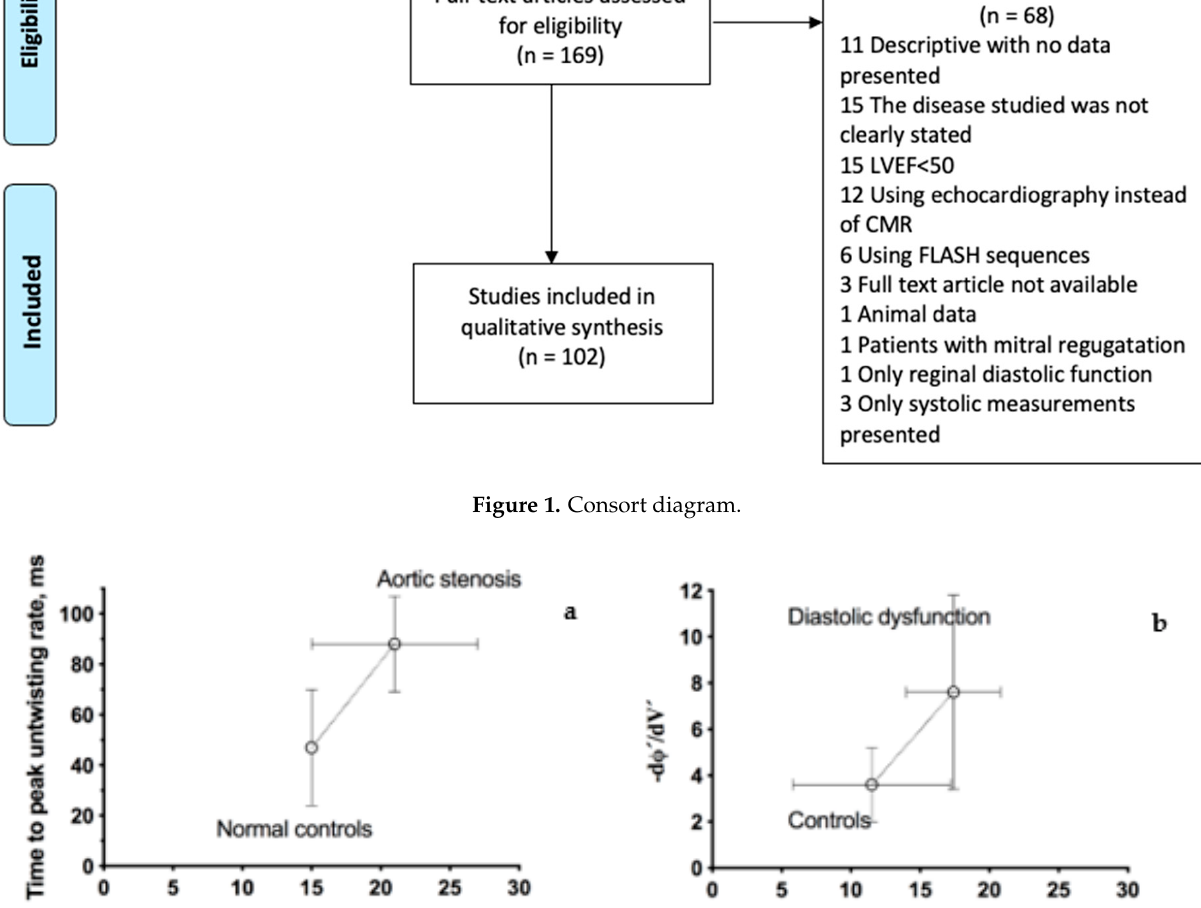
Figure 2. CMR tagging—brief description. Graphic presentation of CMR-assessed parameters of diastolic dysfunction. Connecting lines indicate that estimates come from the same study. References are from the left top corner; ( a ) time to peak untwisting rate (ms) [12]; ( b ) peak change of the torsion shear angle versus volume curve in the early diastole ( − d φ ’/dV’) [13]; ( c ) early peak filling rate (Early PFR, mL/sec) [14]; ( d ) early peak filling rate indexed to LV end-diastolic volume (ePEF/LVEDV, ms) [15,16] and [17] (only patients with reduced diastolic function, please see text); ( e ) left atrium total emptying fraction (%) [14,18,19]; ( f ) left atrium passive emptying fraction (%) [18,19]; ( g ) circumferential-myocardial strain rate from feature tracking (% s − 1 ) [20]; and ( h ) left atrium total longitudinal strain from feature tracking (%) [18,21,22].